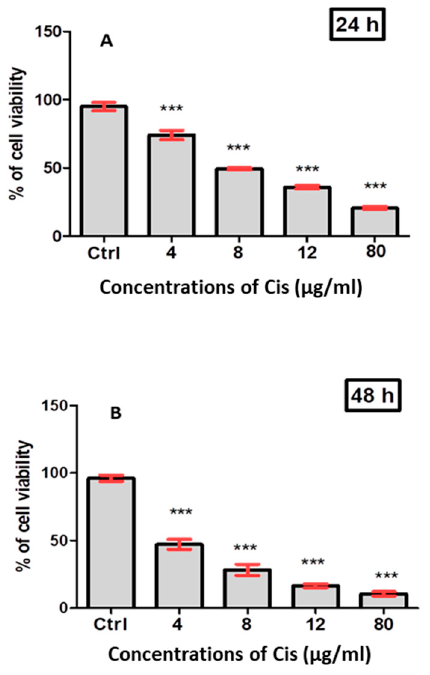
Figure 3. Effect of different concentrations of cisplatin (Cis) on the survival of A549 after ( A ) 24 h and ( B ) 48 h of treatment. The results are expressed as the percentage of control cell (0 mg/mL cisplatin) viability (Ctrl). Each value represents the mean ± SD of triplicates obtained in five independent experiments. *** p < 0.001.